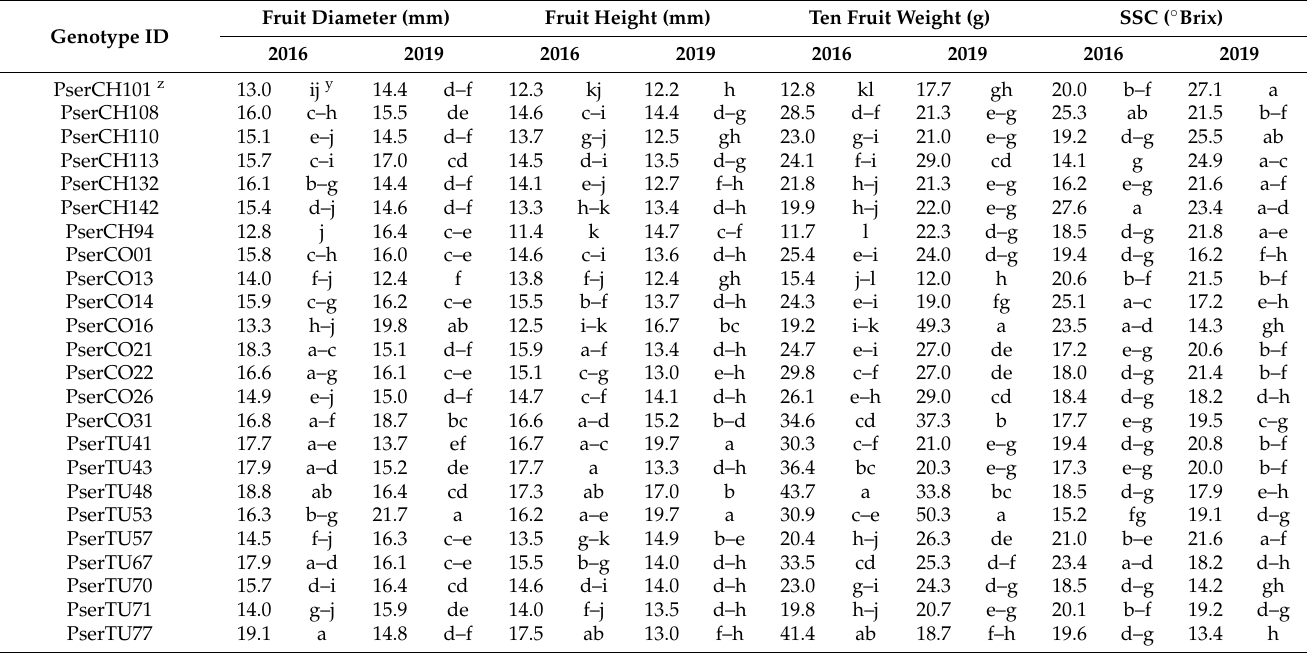
z Genotype: first letter represents the genus (P = Prunus ), next three letters represent the species (ser = serotina ), and the following letters represent the province of origin in Ecuador and collection number (CH101—Chimborazo collection 101). y Different letters within a column indicate significant difference between genotypes, using LSD test at p ≤